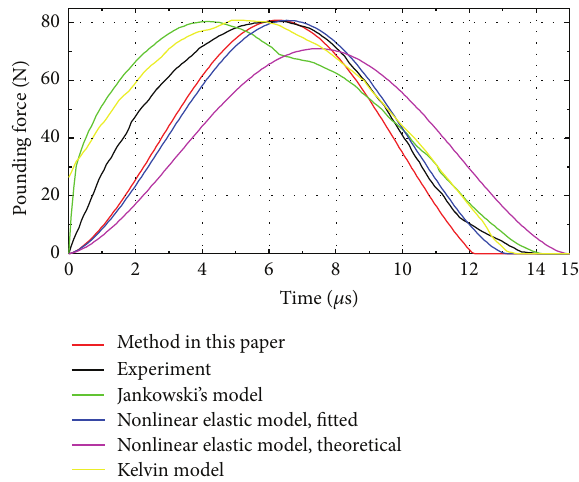
Figure 6: Time histories of pounding force of the steel ball dropping onto a rigid